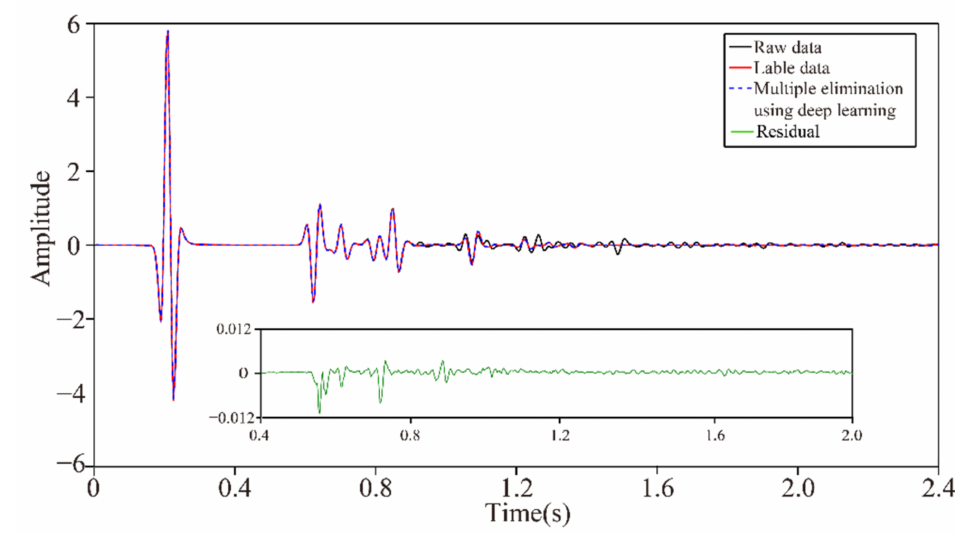
Figure 15. A comparison of 300th traces from Figure